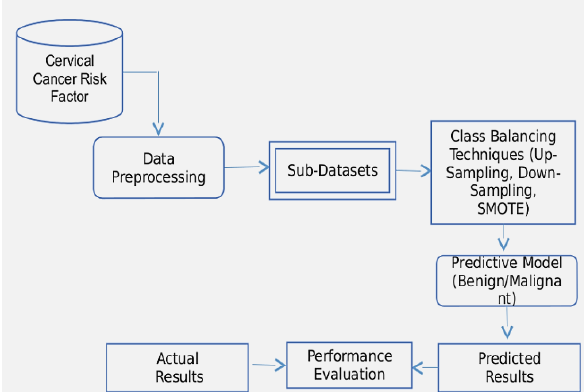
Figure 1 . Proposed